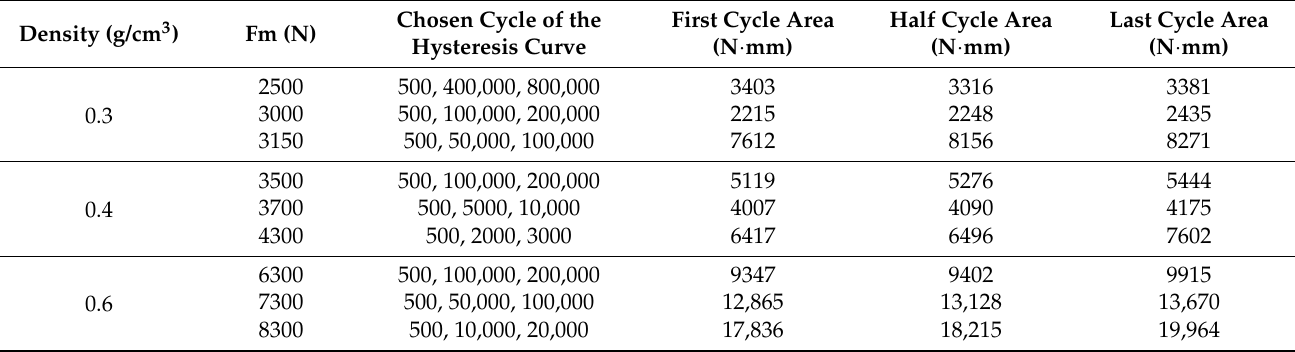
Table 5. Comparisons of the area of the hysteresis curve.